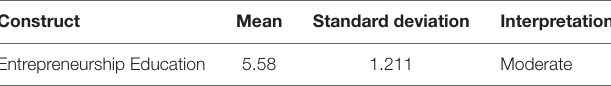
TABLE 2 | Mean and standard deviation of entrepreneurship education.